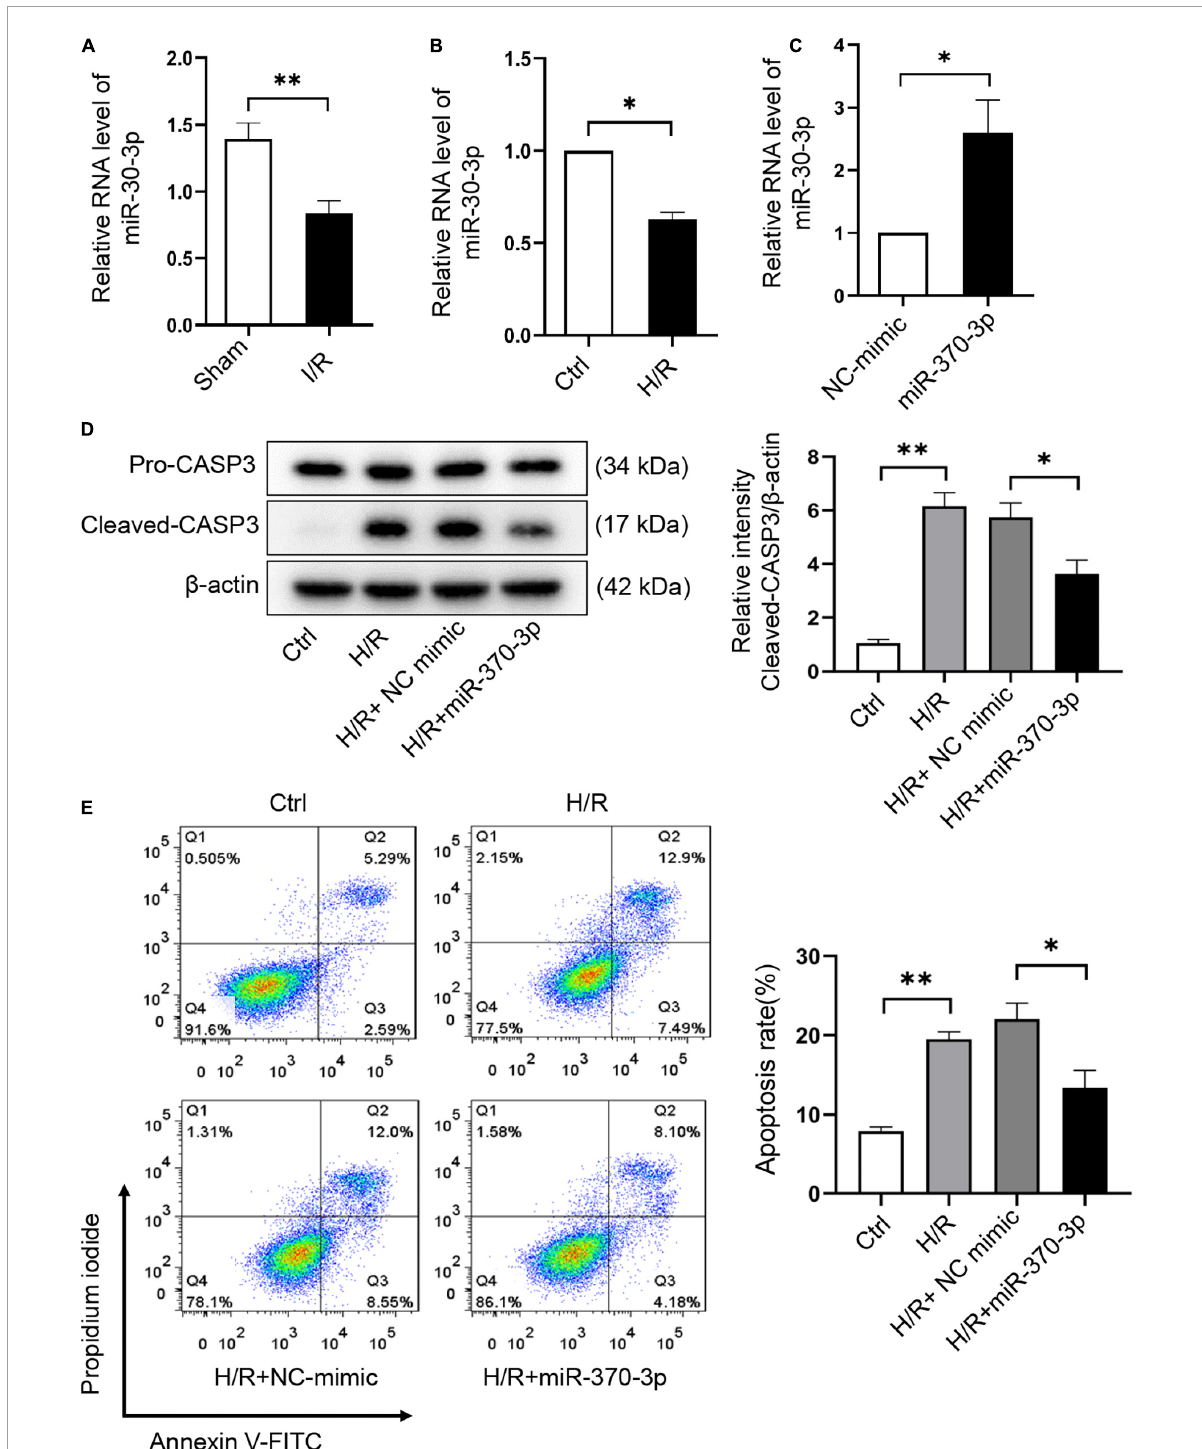
FIGURE6 MiR-370-3p overexpression suppresses the apoptosis triggered by H/R in cardiomyocytes. (A) The analysis of miR-370-3p expression in I/R (45’/3 hr) and sham mice hearts was carried out through qRT-PCR ( n = 5). (B) The analysis of miR-370-3p expression in Ctrl and H/R cells was employed via qRT-PCR ( n = 3). (C) The analysis of miR-370-3p expression in H9c2 cells with or without miR-370-3p mimics was conducted through qRT-PCR ( n = 3). (D) Protein levels of caspase-3 and cleaved-caspase-3 in different groups of cells were tested via Western blot ( n = 3). (E) The apoptotic cell rate in H9c2 cells was examined via flow cytometry ( n = 3). All the data are described as the mean ± SD. * P < 0.05, ** P <